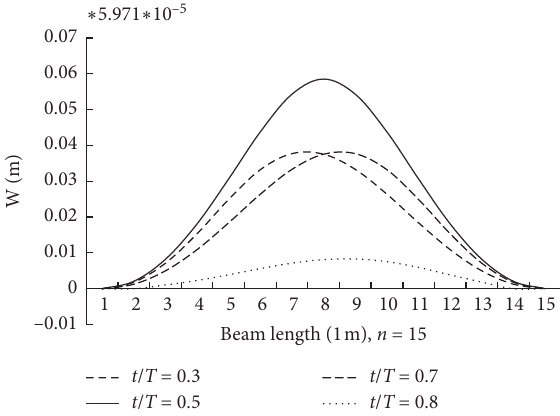
Figure 5: S-S EB Beam (1) deflection, F �